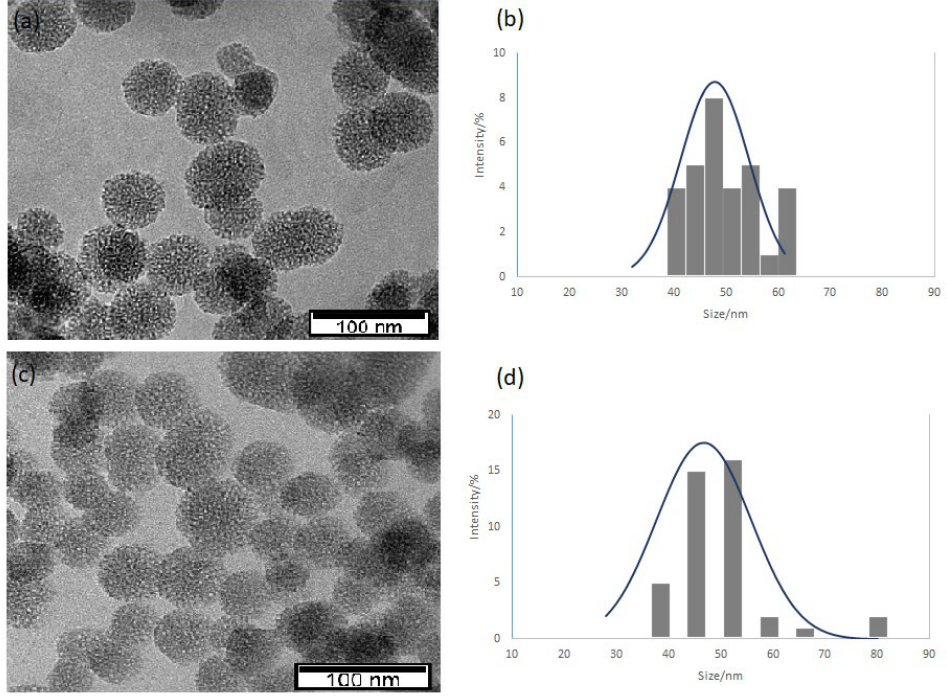
Figure 3. TEM images of ( a ) MSiNPs and ( c ) MSiNP-DTC NPs and their respective size distribution histograms ( b , d ).